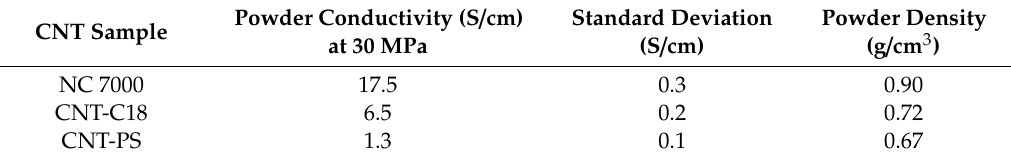
Table 1. Powder conductivity of NC 7000 and functionalized CNTs at 30 MPa.